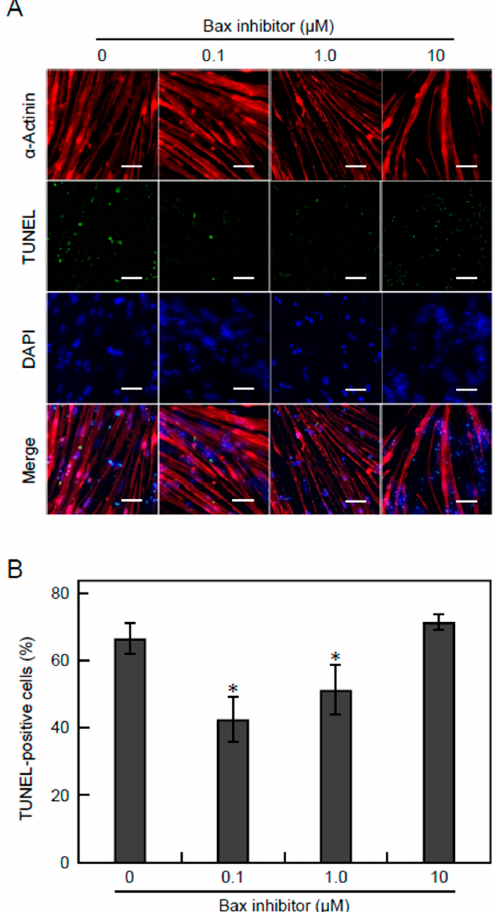
Figure 5. Effect of Bax inhibitor on apoptosis of D-iPS cell-derived myotubes. D-iPS cell-derived myotubes were cultured with EPS (0.30 V/mm). Bax inhibitor peptide was added to culture medium at varying concentrations (0.1, 1.0, and 10 µM). ( A ) Fluorescence microscopy of cells stained with anti- α -actinin antibody (red) and DAPI (blue). Apoptotic cells were stained by the TUNEL assay (green). Scale bar is 50 µm. ( B ) Quantitative analysis of the percentage of TUNEL-positive myotubes. Data are expressed as the mean ± SD ( n = 3). * p < 0.05 vs without Bax inhibitor.